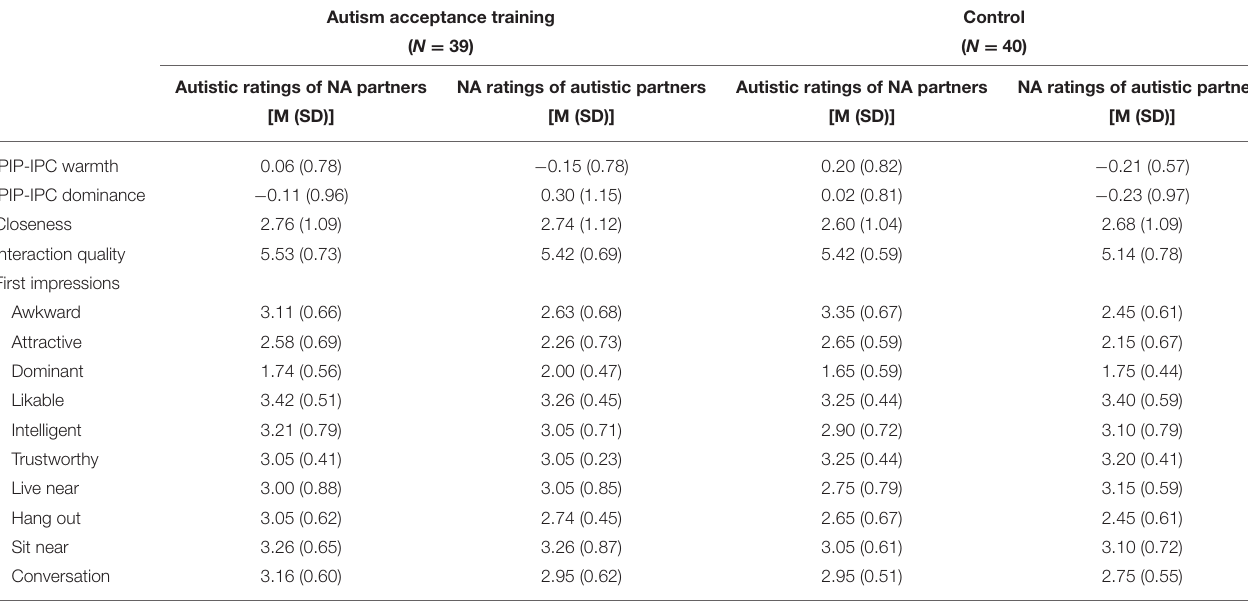
TABLE 4 | Means and standard deviations of partner ratings.